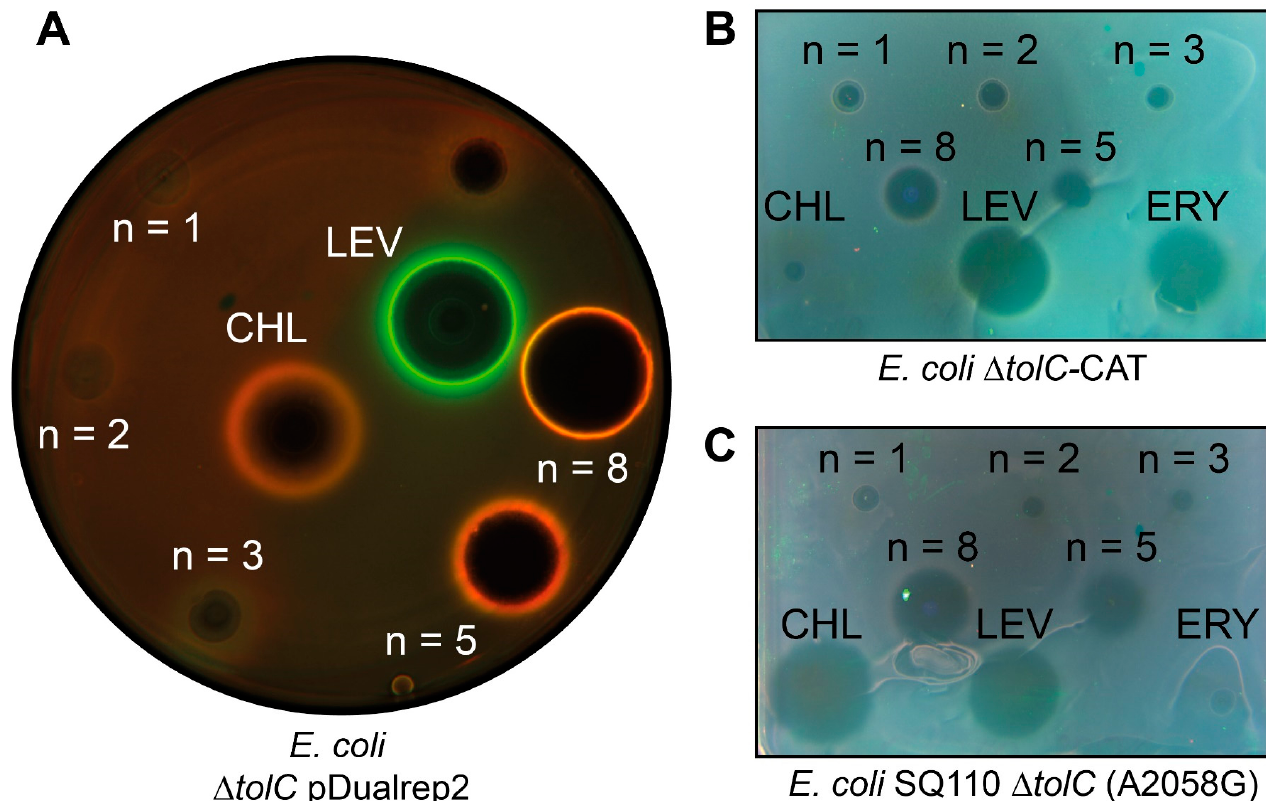
Figure 2. Antibacterial activity of CAM-Cn-BER, n = 1, 2, 3, 5, 8. Levofloxacin (LEV),